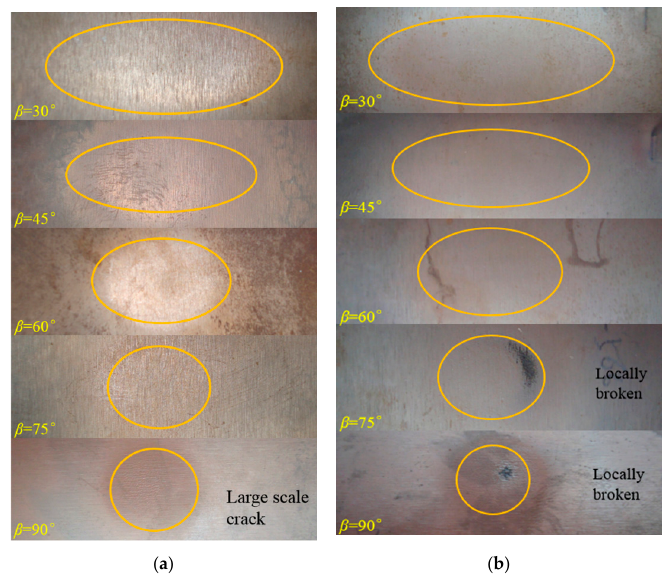
Figure 15. Macroscopic erosion morphology of the boronized coating at 210 m/s and 566 ℃ (D 32 = 65 μ m): ( a ) 210 m/s; ( b ) 320 m/s.